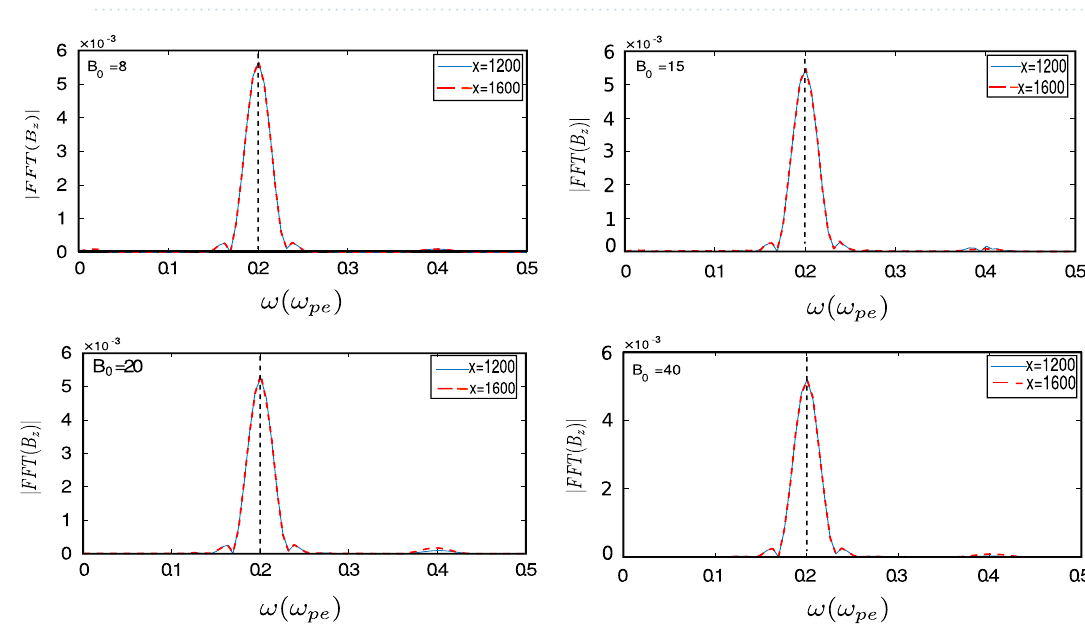
Figure 6. Spatial variation of number density of electrons and ions for the three cases at different times showing that plasma density gets perturbed at the interface for case ( A ) whereas for case ( B ), we observe density fluctuations in the bulk plasma as well which retain themselves even after laser has moved out of the simulation box ( t = 1000 ). For case ( C ), on the other hand, we observe some density perturbations in the bulk plasma at the time of interaction with laser ( t = 500 ) but these fluctuations are not retained by plasma after the interaction with laser is over.